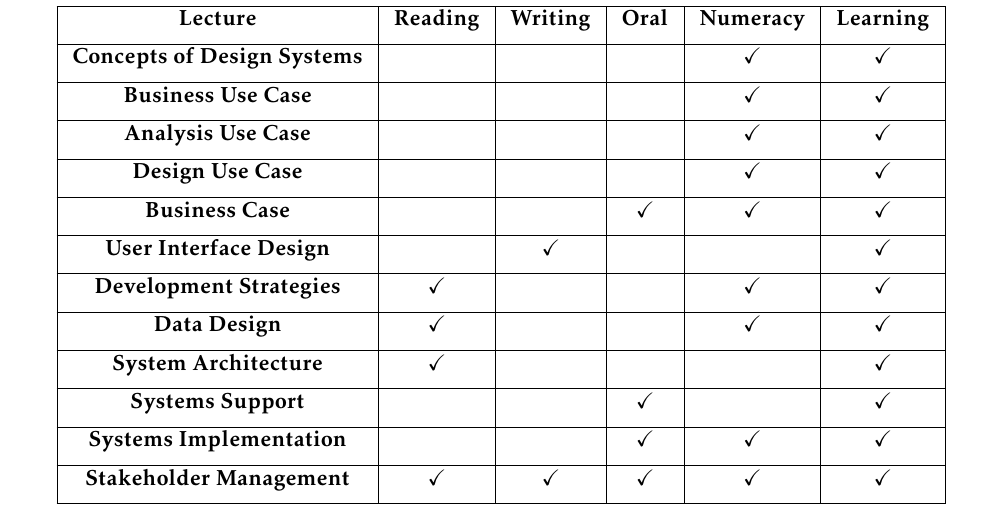
Table 4. Mapping of the Assessment Tasks with Core